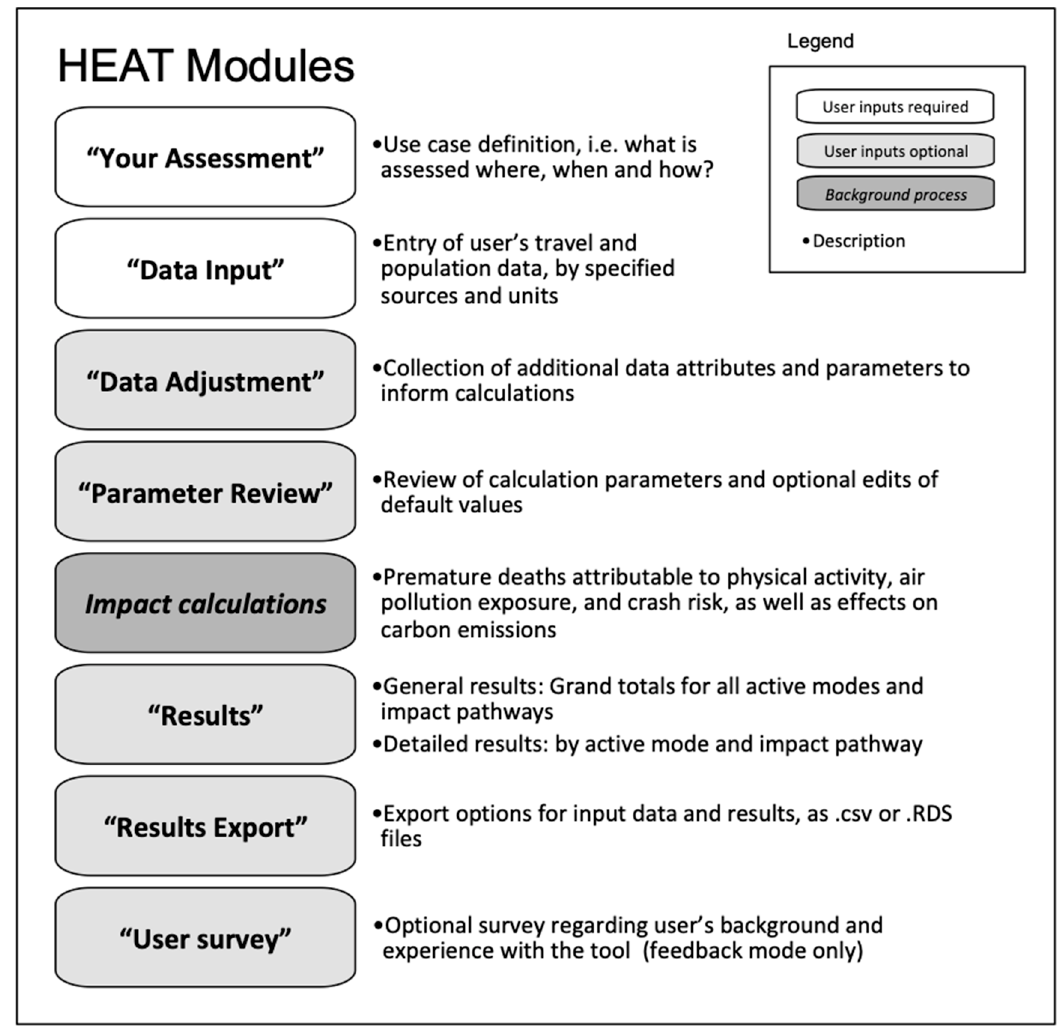
Figure 4. Flow of the Health Economic Assessment Tool for walking and cycling.